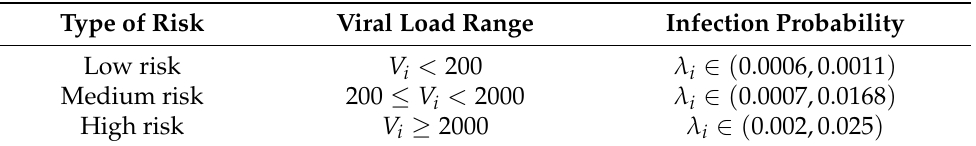
Table 3. Values for the infection probability λ i according to the number of vir/mm 3 found in the immune system